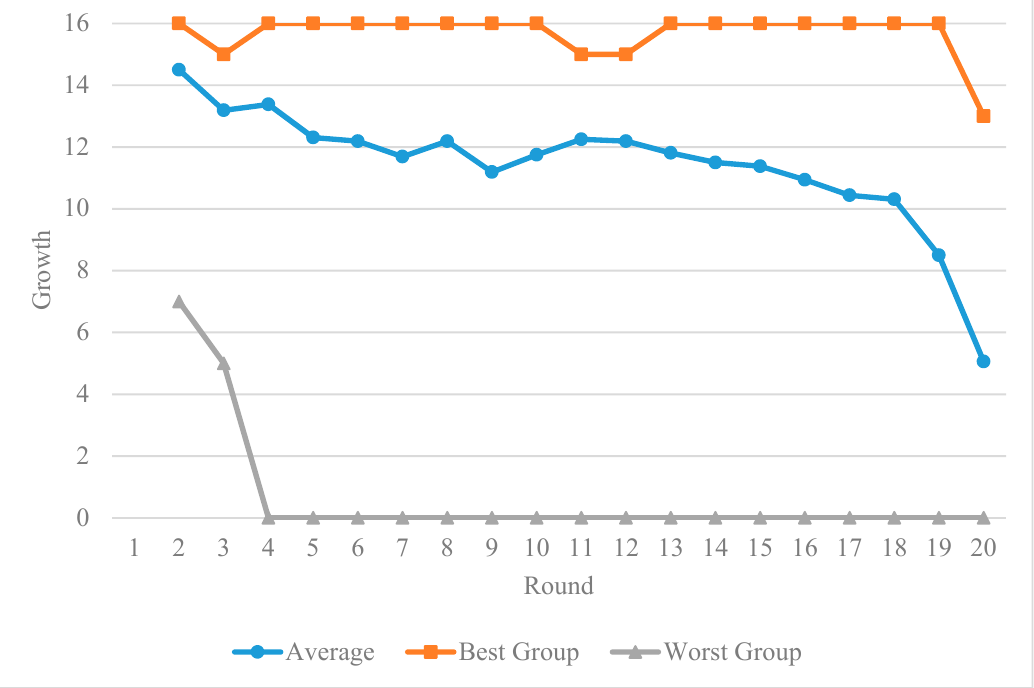
Figure A3. Stock at the end of each round (for all 16 groups).